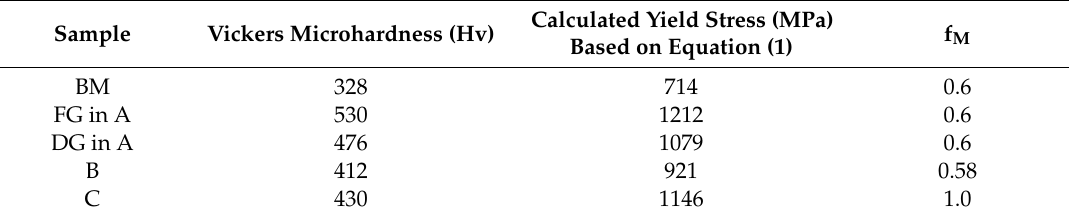
Table 2. Summary of Vickers microhardness, calculated yield stress based on Equation (1) and f M for the BM and samples A (including FG, and DG zones), B, and